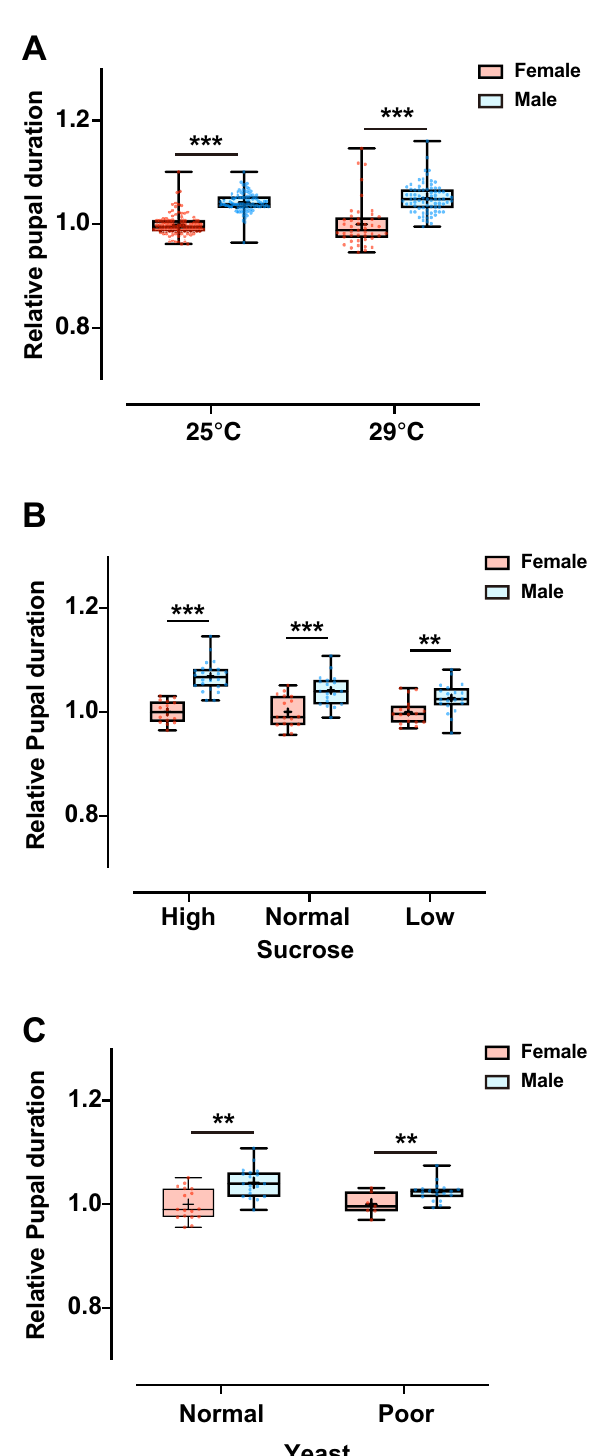
Figure 1. Robustness of the protogyny phenotype under varying environmental conditions. ( A ) Effect of varying temperatures (25 and 29 °C) on rearing. ( B ) Effect of sucrose concentration in the media. High, normal, and low sucrose media contained 1, 0.15, and 0.05 M sucrose, respectively, in addition to the other components of the normal medium. ( C ) Effect of yeast concentration in the media. The poor yeast medium contained one- third of the yeast concentration of standard fly medium. The number of flies analyzed is indicated in parentheses on each graph. Whiskers indicate minimum and maximum values (*** p < 0.001, ** p < 0.01 by Student’s unpaired t